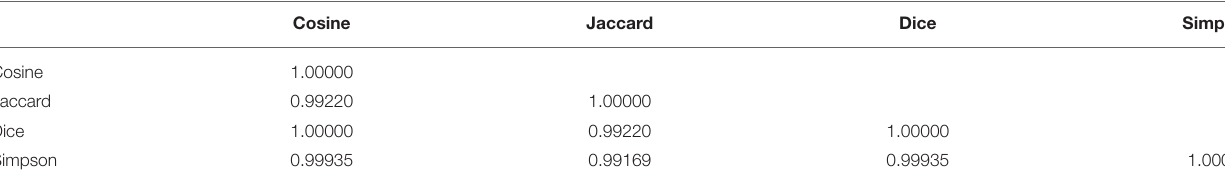
TABLE 5 | Correlation between different similarity measures. Cosine Jaccard Dice